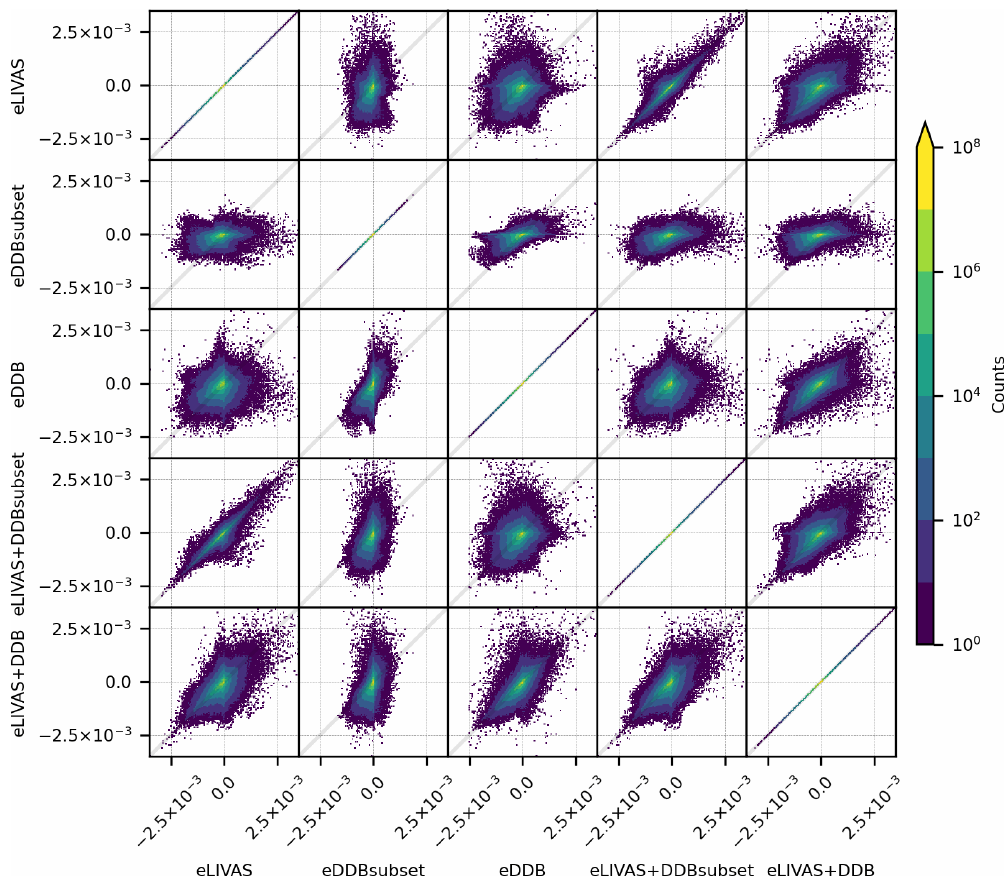
Figure 11. Similar to Fig. 10 but for the dust extinction coefficient. The width of the bins is 4 . 63 × 10 − 5 m − 1